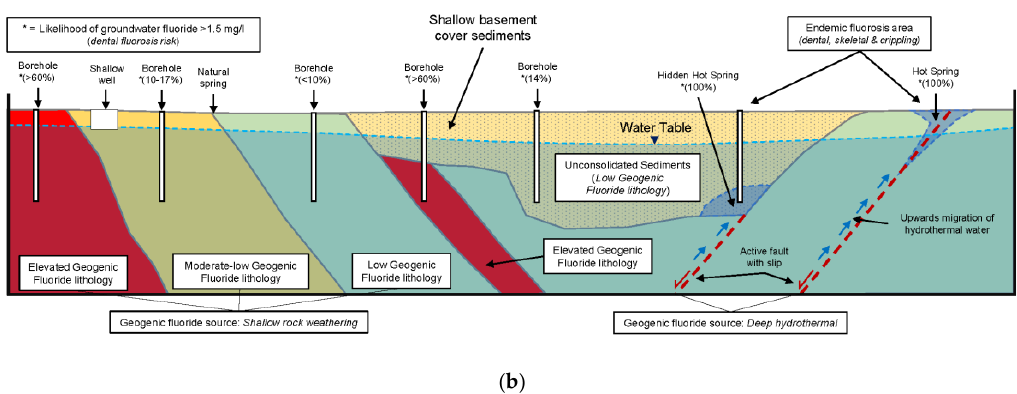
Figure 7. ( a ) Geogenic fluoride groundwater risk map of Malawi. The map is based on the geological map of Malawi (Figure 3), where each lithology is displayed per geogenic fluoride risk classification (Figure 4a) as zones of generic groundwater vulnerability to geogenic fluoride from shallow rock weathering. Hot springs are displayed as site-specific sources of geogenic fluoride from deep hydrothermal sources. The map includes estimated numbers of people vulnerable from geogenic groundwater fluoride in each zone (based on the number of people normally using each water point). ( b ) Conceptual model of known and hypothesised geogenic fluoride sources from a.